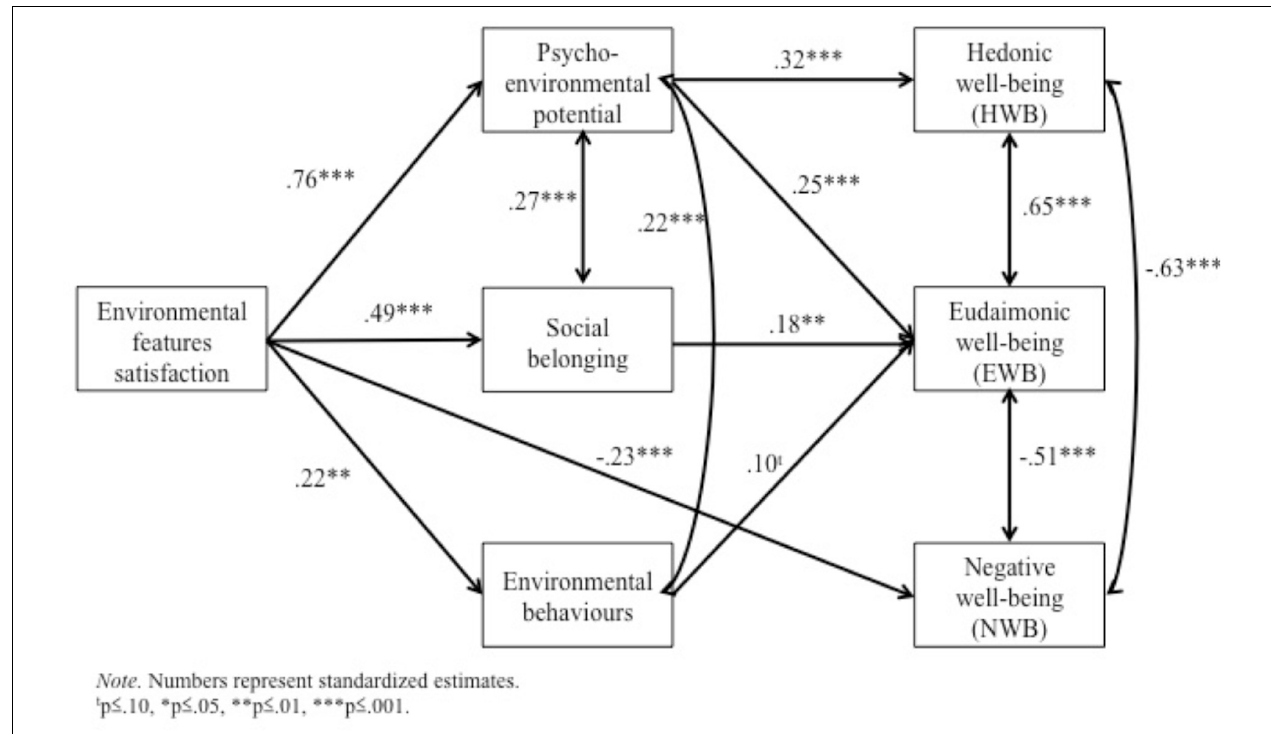
FIGURE 1 | Final path analysis model of the pathways underlying the associations between wellbeing variables and environmental features. TABLE 5 | Bootstrap standardized estimates and 95% bias-corrected confidence intervals for direct and indirect effects of environmental features (EFR) on wellbeing ( N = 213). DV: HW DV: EW DV: